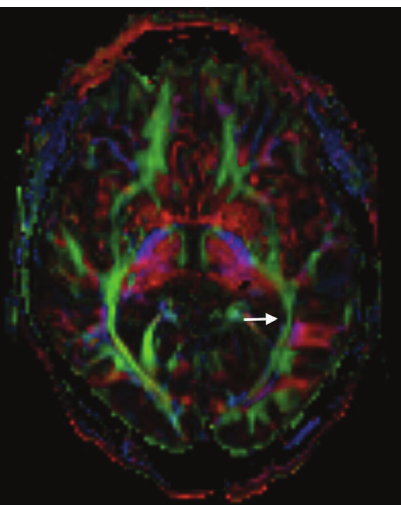
Figure 2: Color coded fractional anisotropy (FA) maps obtained from the diffusion-tensor imaging (DTI) show collateral tissue preservation, with only small areas of decrease in FA in the left inferior longitudinal fasciculus (long